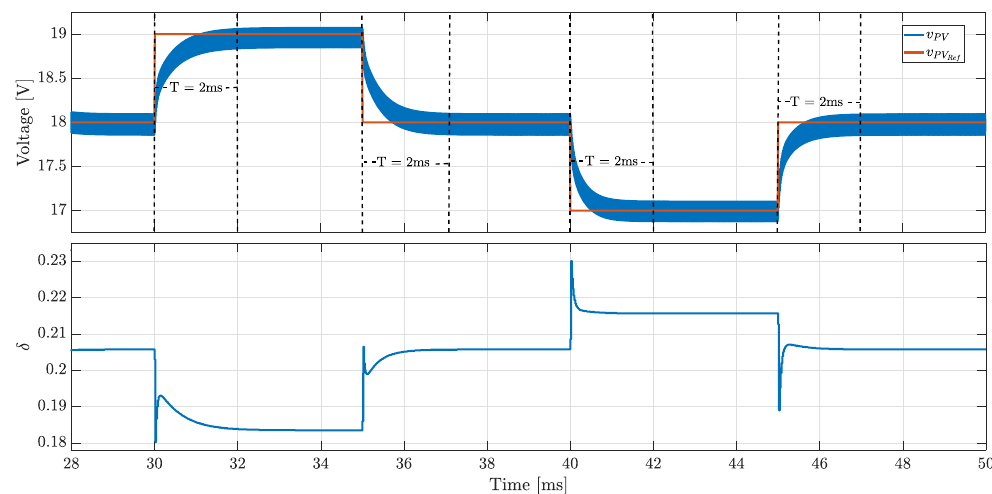
Figure 15. Performance of the control systems to step changes on the v PV reference.